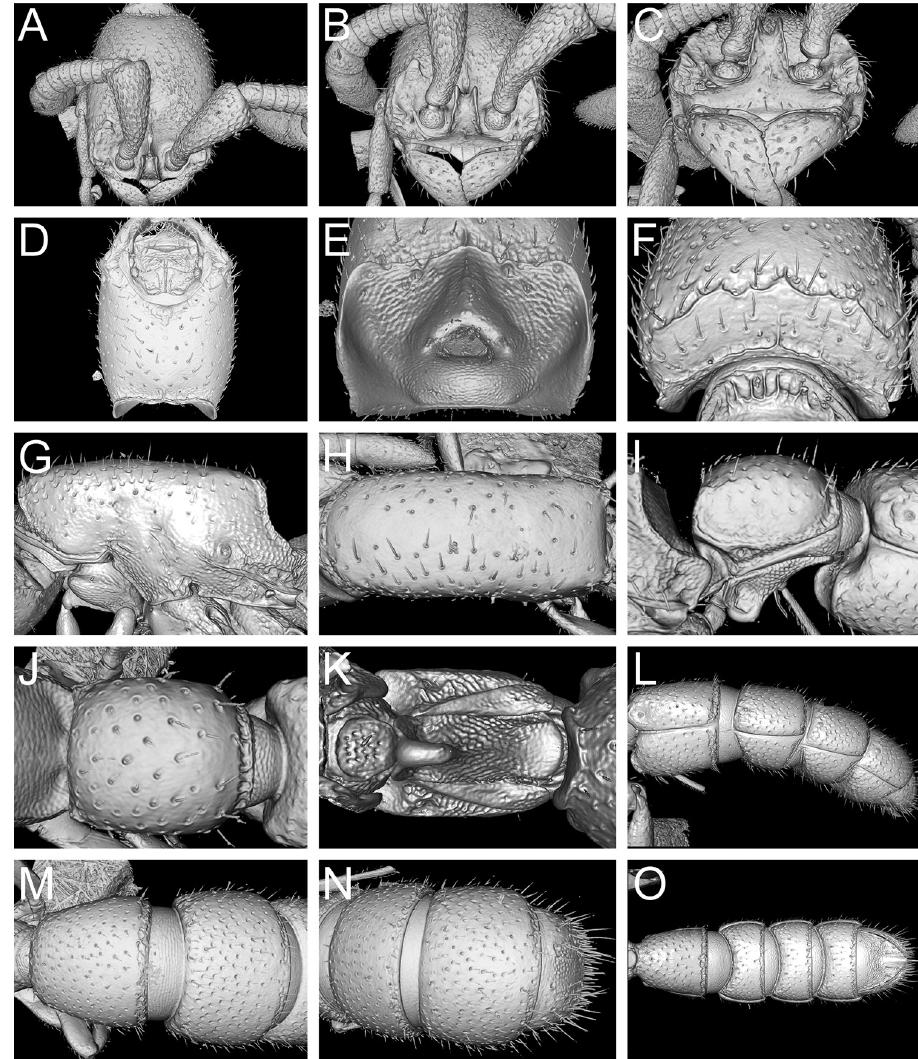
Figure 8. Shaded surface display volume renderings of 3D models of Zasphinctus obamai sp. n. paratype worker (CASENT0764127). A Head in full-face dorsal view B Head in anterodorsal view C Anterior cephalic dorsum and mandibles in anterodorsal view D Head in ventral view E Occiput in posterior view (ventral head facing upwards) F Head in posterodorsal view G Mesosoma in profile H Mesosoma in dorsal view I Abdominal segment II (petiole) in profile J Abdominal segment II (petiole) in dorsal view K Abdominal segment II (petiole) in ventral view L Abdominal segments III–VII in profile M Abdominal segments III and IV in dorsal view N Abdominal segments V–VII in dorsal view O Abdominal segments III–VII in ventral